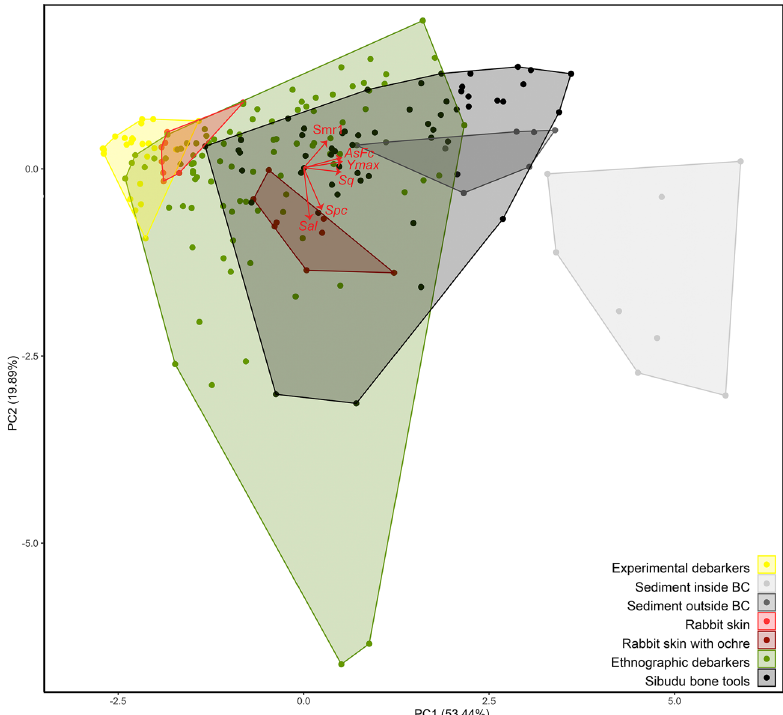
Figure 7. Principal Component Analysis based on six textural parameters. Between-group comparison of the range of variation in textural parameter values on the first two principal components (PC1: 53.44%; PC2: 19.89%). The values recorded on archaeological specimens largely overlap with those measured on ethnographic debarkers, experimental tools used to process rabbit skin with an ochre mixture and to dig in humus-rich soil. BC = Border